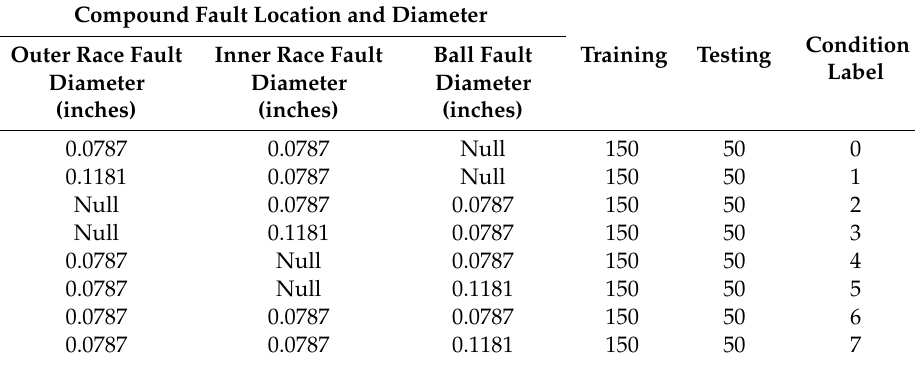
Figure 12. The location of the bearing faults: outer race fault ( a ); inner race fault ( b ); ball fault ( c ); and combination of parts ( d ). Table 5. Composition of CUT-2 experimental samples.